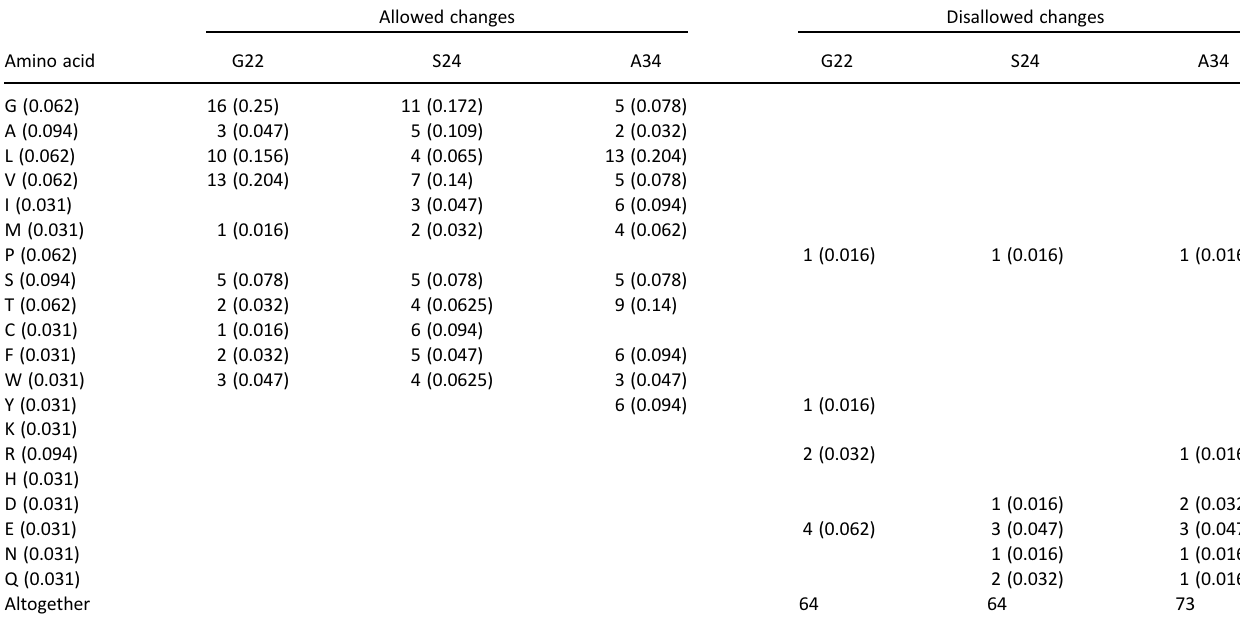
The first column indicates amino acids and their expected fractional appearances in parentheses. Next three columns show amino acids changes which gave active CD39 and their calculated fractional appearances based on the total number of amino acids at the mutated position. Last three columns show amino acids which were detrimental for CD39